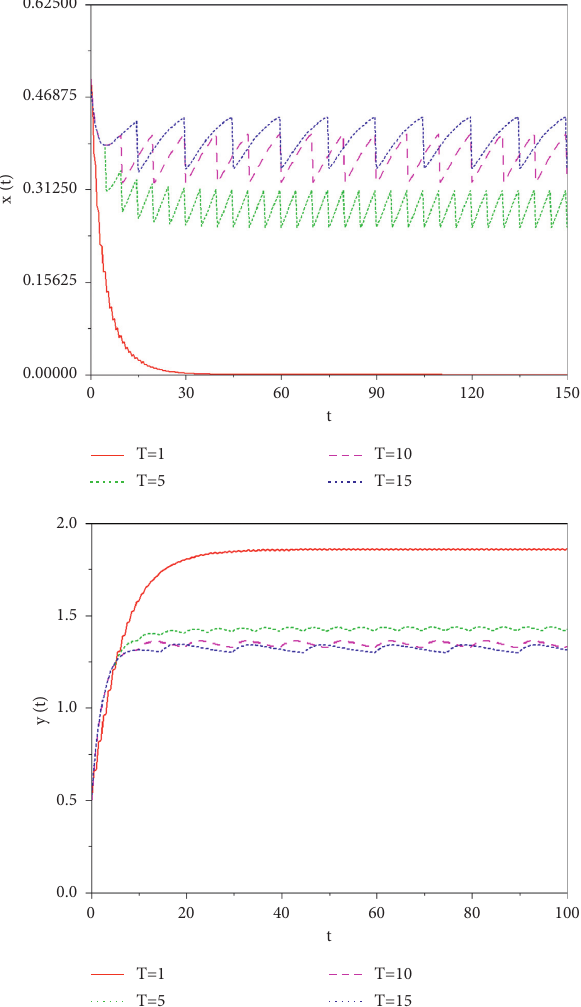
Figure 4: Computer simulations of systems (5) and (6) for T � 1 , 5 , 10 , 15 when a � 0 . 91, a 0 . 34 ,a 7 � 0 . 65 , μ � 0 . 01, ρ � 0 . 2 ,z ( 0 ) � 0 . 5 , and w ( 0 ) � 0 . 5